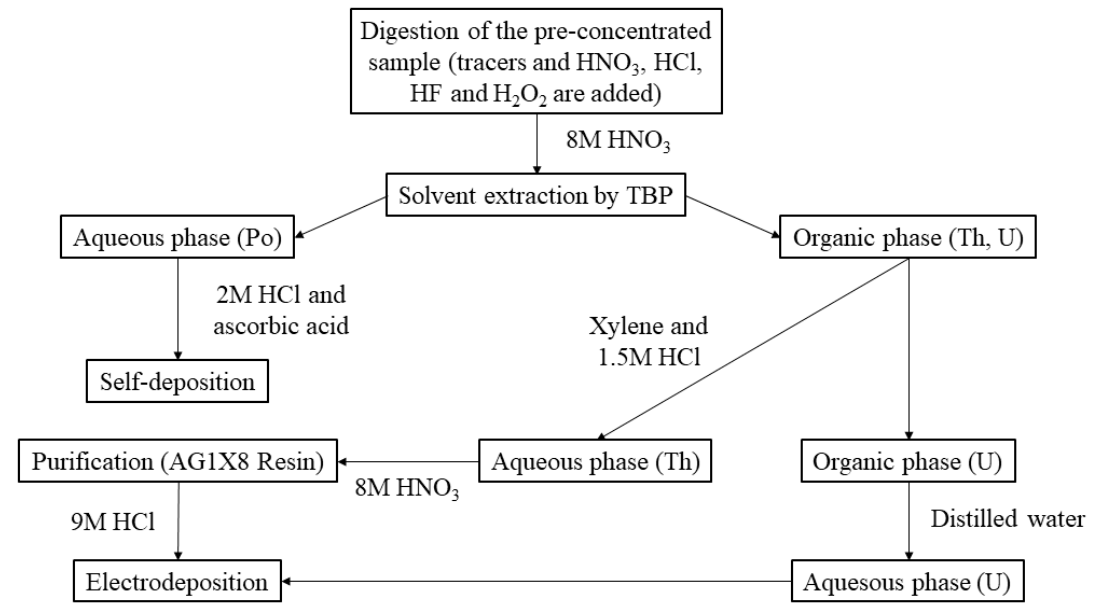
Figure 1. Scheme for the radiochemical method used to extract the Po, Th, and U isotopes.